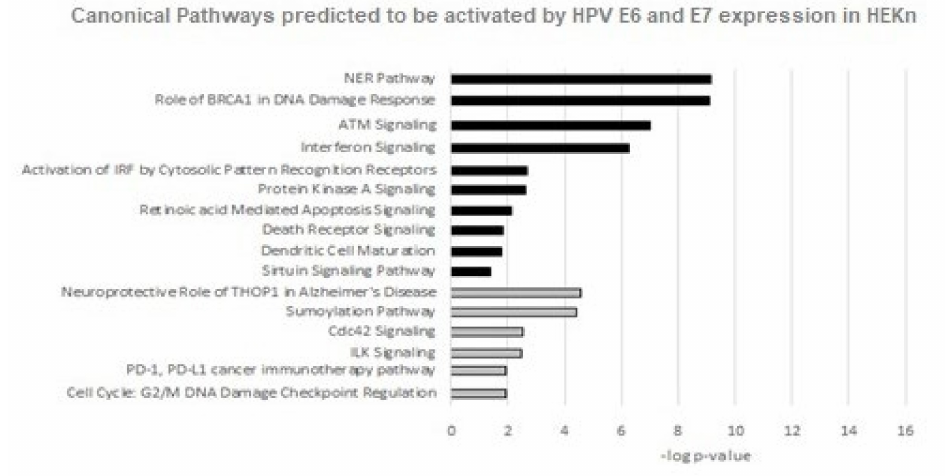
Figure 7. Canonical pathways predicted to be affected in HEKn cells expressing HPV16 E6 and E7 oncoproteins. Included in this analysis were proteins significantly differentially expressed (adjusted p -value ≤ 0.02) by ≥± 1.5-fold change. Black shading indicates a predicted increase in activity and grey shading indicates a predicted inhibition of canonical pathway, based on current evidence in the Qiagen Ingenuity Pathway